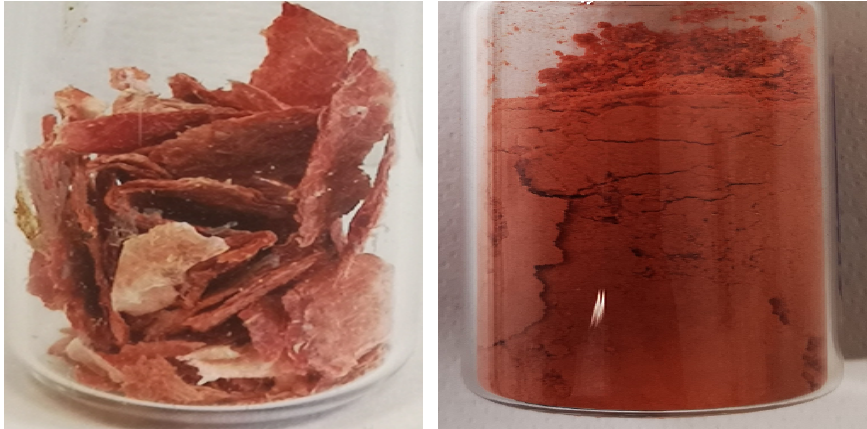
Figure 2. Images of the G_WDF sample: flakes immediately after the drying process ( left ), and powder after the subsequent grinding process ( right ).